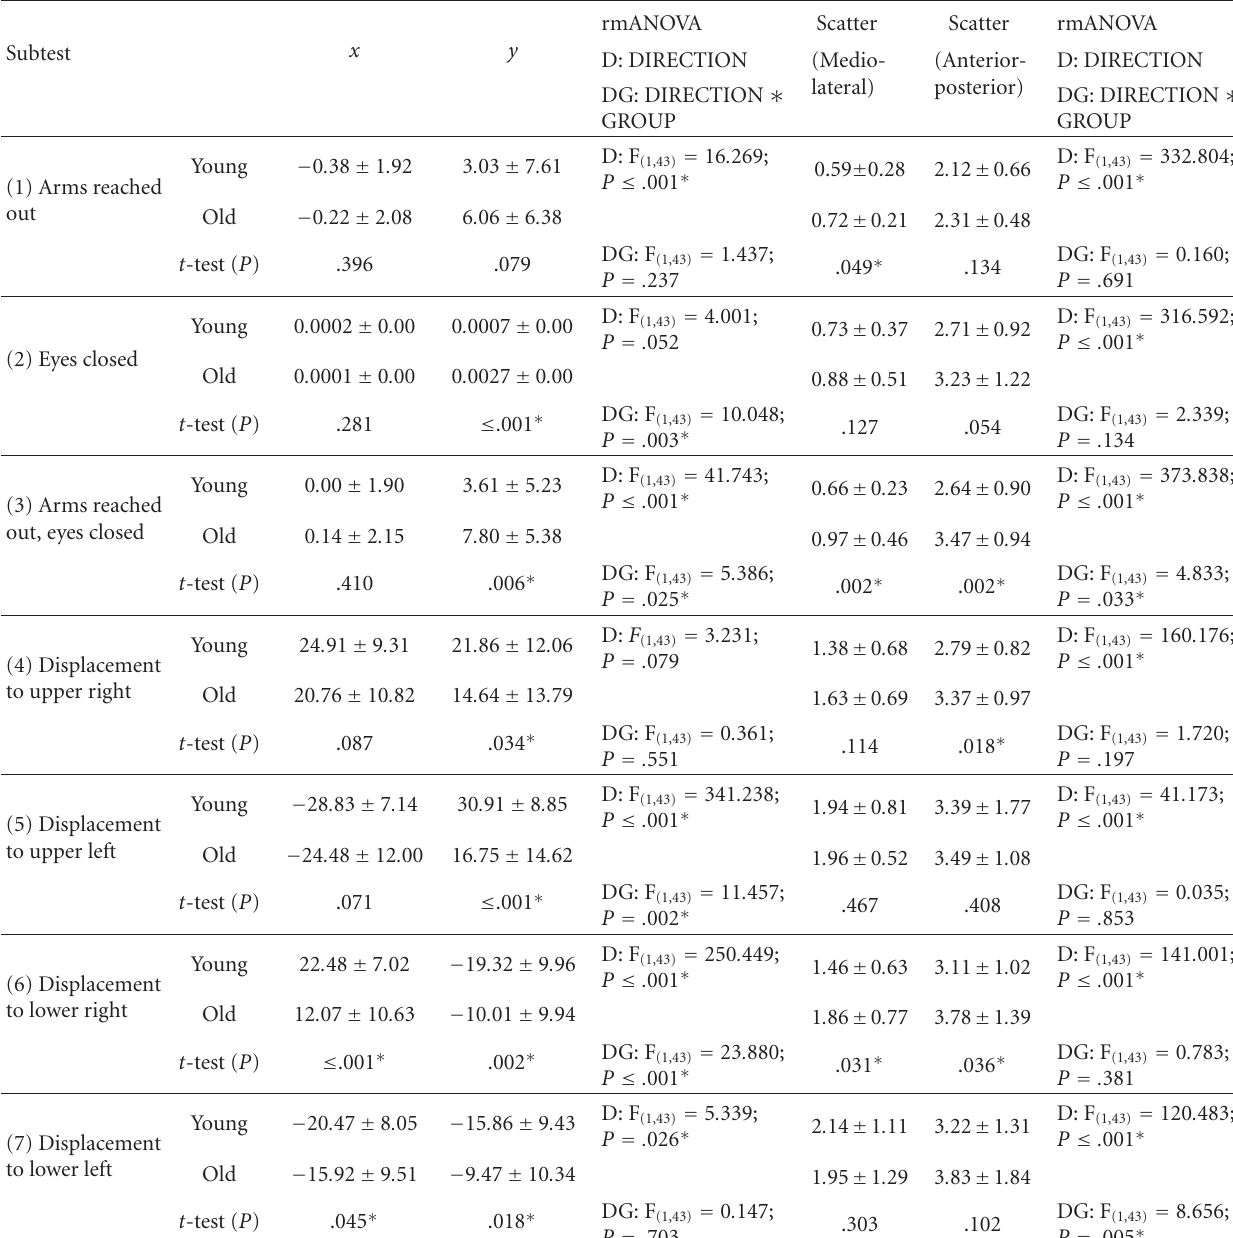
Table 1: Posturographic performance of young and older subjects as determined in subtests 1–7 . Data are given as average percent shift of raw sensor data (% RSD) for x - and y -coordinates (Mean ± SD). Repeated measures ANOVA (rmANOVA) and t -tests were used to